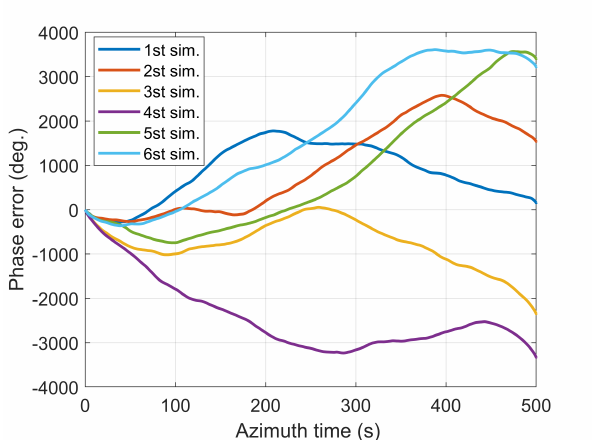
Figure 10. Simulated oscillator phase errors in 500 s data taking.